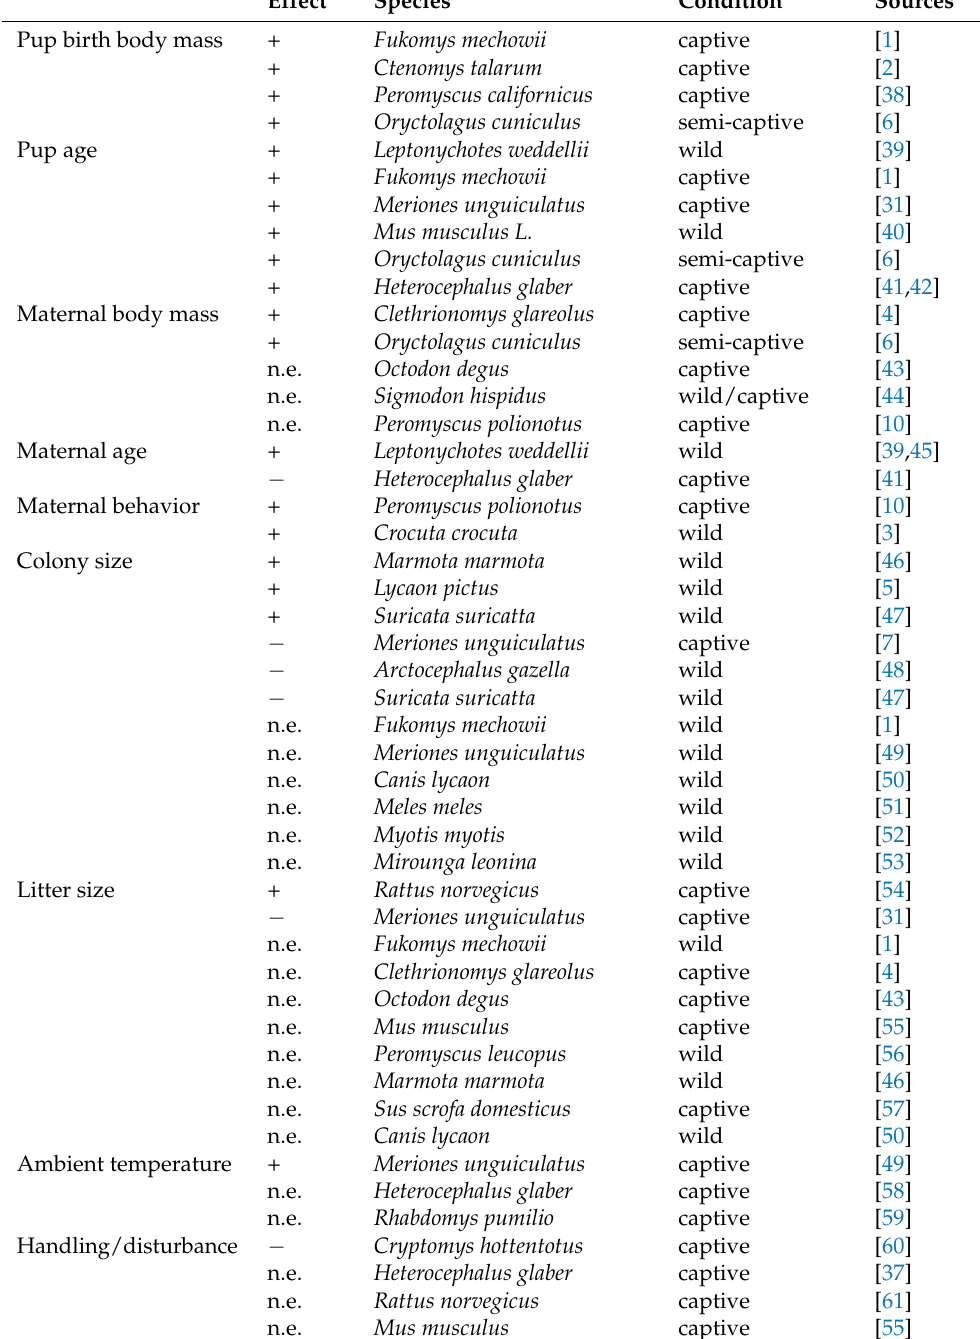
Table 1. Effect of different variables on pup survival in mammals. The effect of variables on pup survival is denoted as positive (+), negative ( − ) and no significant effect (n.e.); studies were conducted